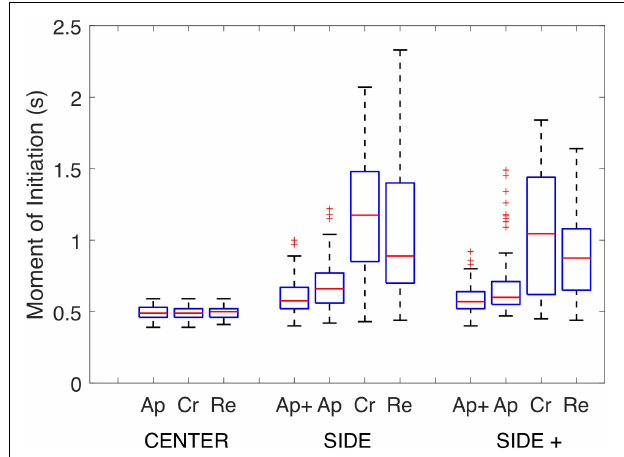
FIGURE 4 | Box plots of the full sets of Moments of Initiation of the first steering action on individual trials under the CENTER, SIDE, and SIDE+ eccentricity conditions for the Approach+ (Ap+), Approach (Ap), Cross (Cr), and Retreat (Re) target directions. Note that the Approach+ target direction was absent under the CENTER eccentricity